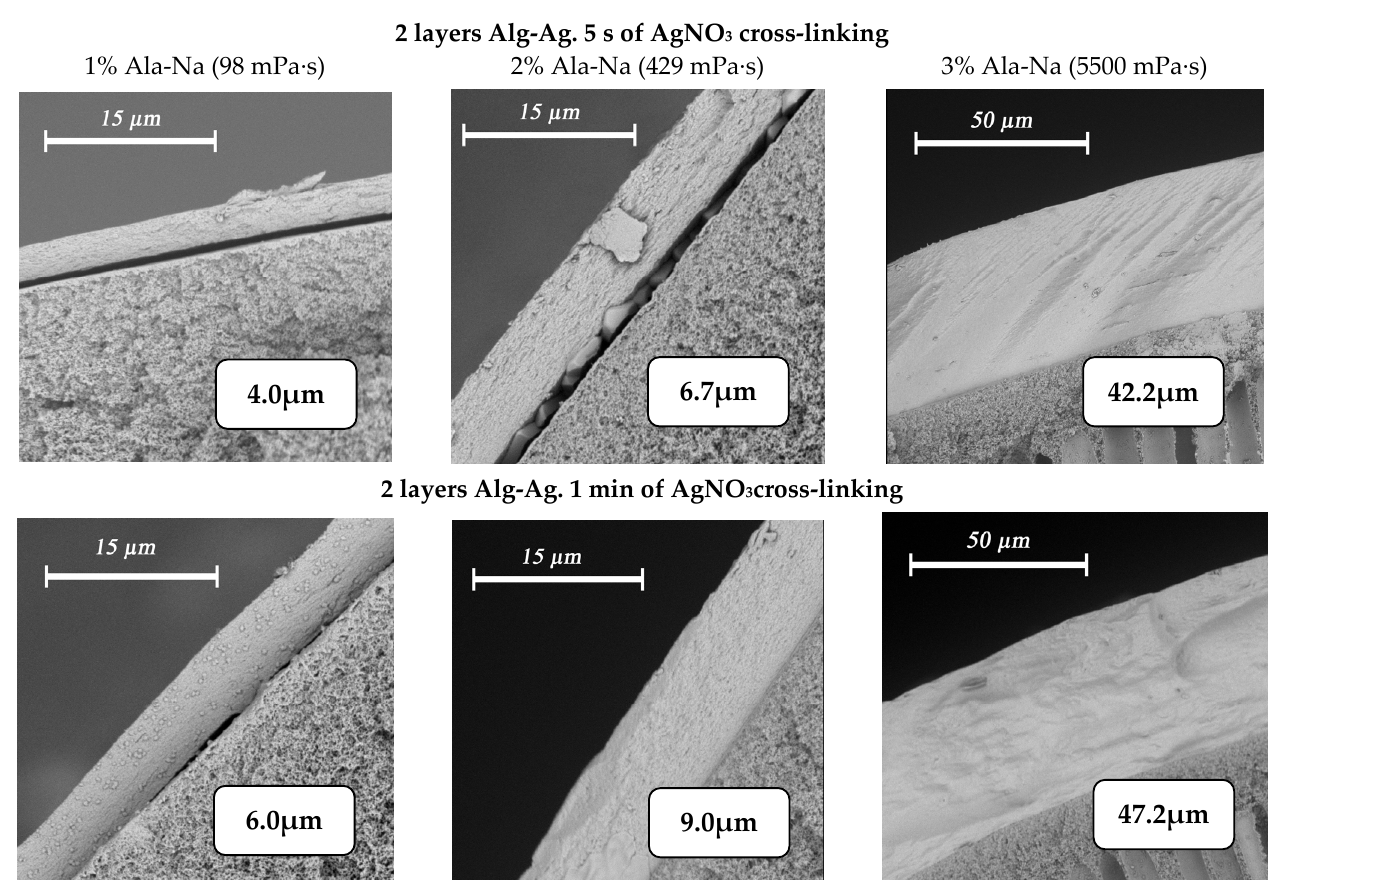
Figure 9. Changes in the thickness of the silver alginate selective layer when varying the alginate concentration (1% wt.—first column, 2% wt.—second column, 3% wt. third column)and crosslinking time of the polymer (two layers—5 s (first row) and 1 min (second row)). The use of lower concentrated alginate solutions, such as 0.1%, did not result in the appearance of a selective layer on the fiber surface (Figure 10).